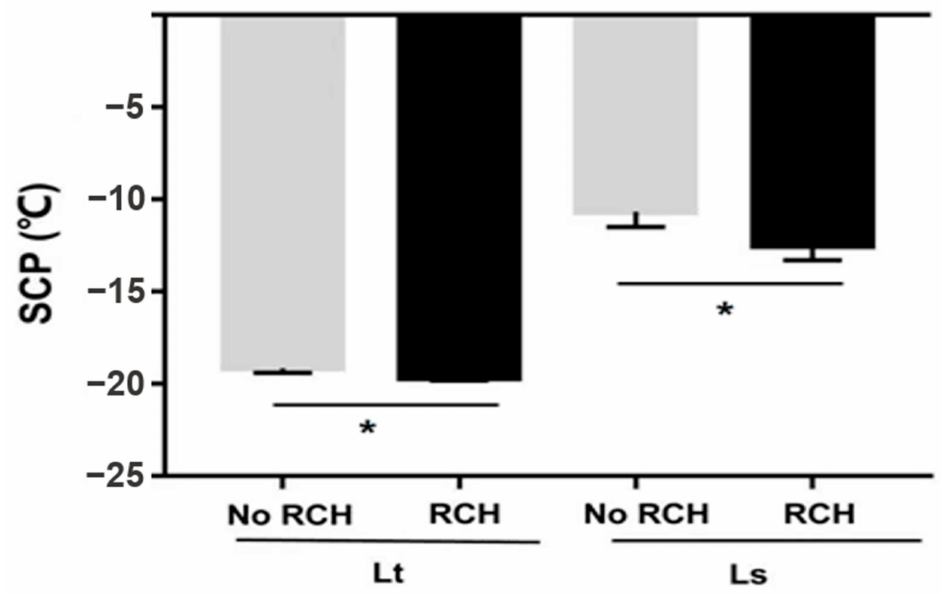
Figure 4. Mean supercooling points (SCP) of L. trifolii and L. sativae pupae in experiments to evaluate the impact of RCH on SCP. Data were analyzed by the Student’s t -test, p < 0.05. Asterisks represent significant differences between RCH and